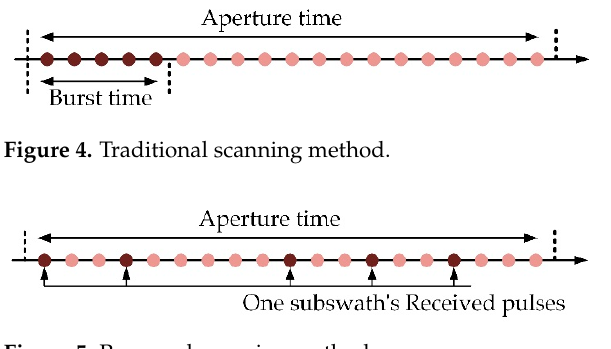
Figure 5. Proposed scanning method.